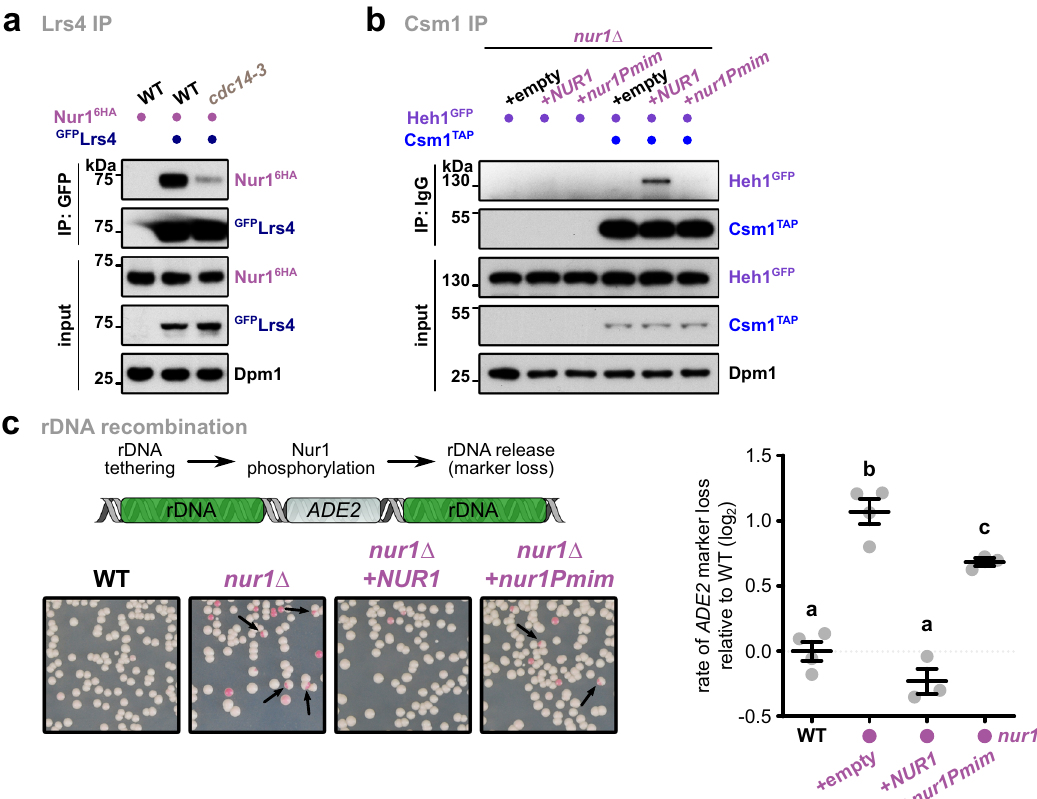
Fig. 3 C-terminal Nur1 phosphorylation disrupts the rDNA tethering complex. a Co-immunoprecipitation of Nur1 6HA with GFP Lrs4 in WT or cdc14-3 mutant cells. Cells were grown at the permissive temperature and shifted to 37°C for 1h. Dpm1 served as loading control. b Co-immunoprecipitation of Heh1 GFP with Csm1 TAP in nur1 Δ cells. The strains were transformed with empty vector or plasmids bearing NUR1 or its phosphomimetic mutant ( nur1Pmim ) expressed from the endogenous promoter. Dpm1 served as loading control. c Quanti fi cation of rDNA recombination rates in WT or nur1 Δ cells as measured by marker loss of an ADE2 marker inserted into rDNA. Cells have been transformed with empty vector or plasmids bearing NUR1 or nur1Pmim expressed from the endogenous promoter. The rate of marker loss is calculated as the ratio of half-sectored colonies (as indicated by the arrows) to the total number of colonies, excluding completely red colonies. Data are mean±SEM of n independent biological replicates ( n = 4 for WT and nur1 Δ ; n = 3 for NUR1 and nur1Pmim ), shown in log 2 scale relative to WT. Statistical analysis was performed using ANOVA, and letters denote signi fi cant differences with a Tukey ’ s post hoc test at P ≤ 0.05. Source data are provided as a Source Data fi